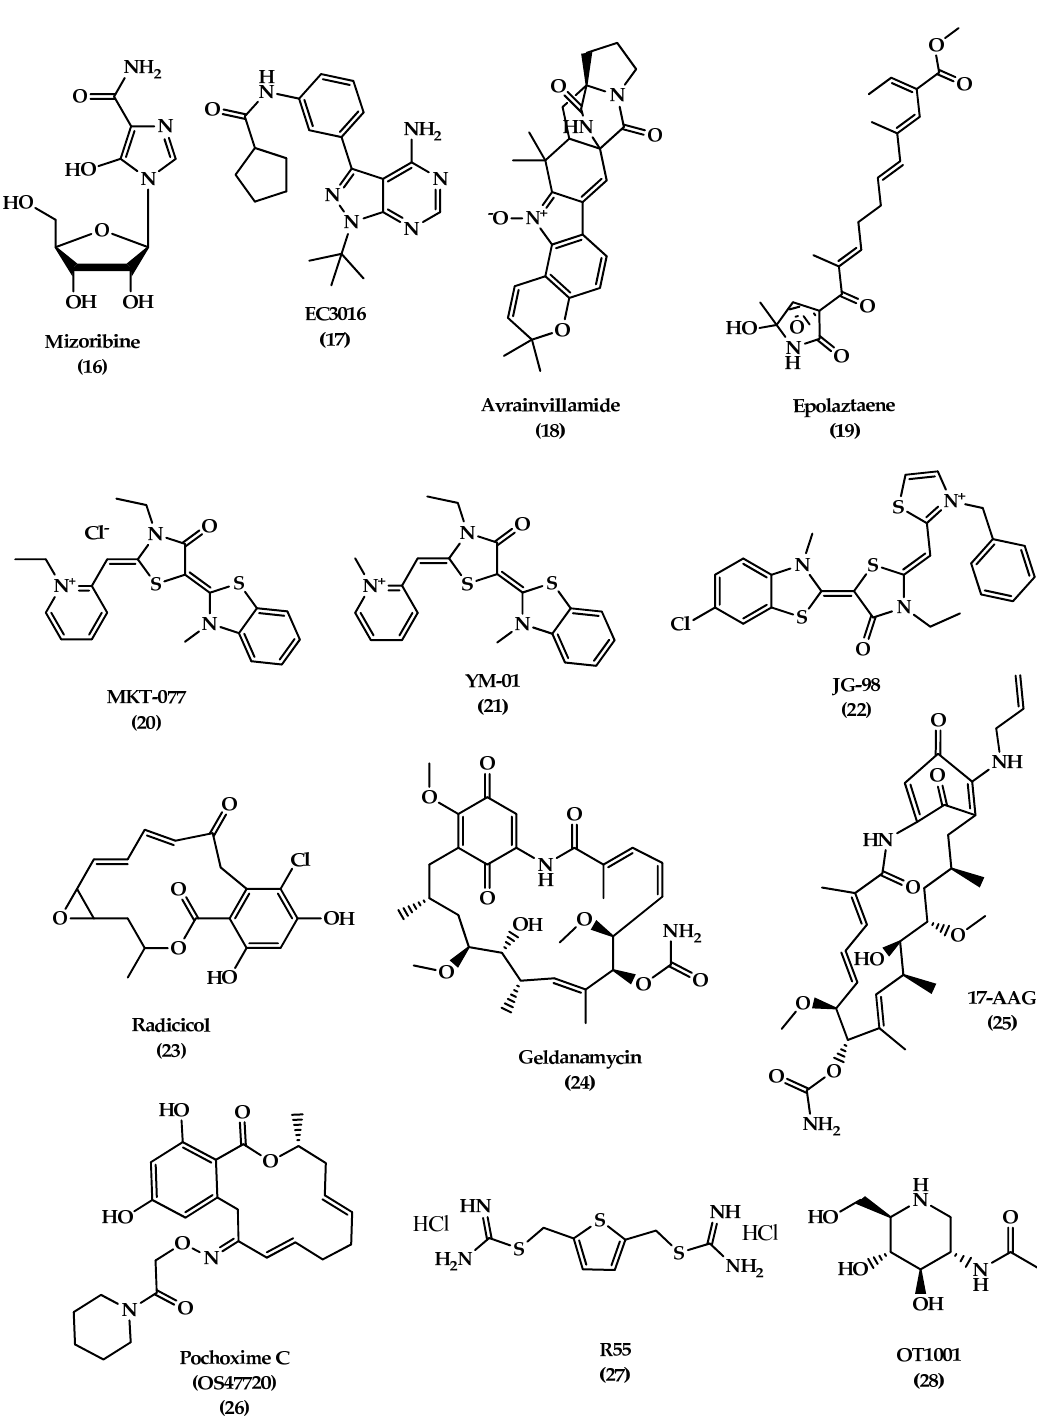
Figure 5. The chemical structures of different chaperone molecules: Mizoribine 16 , EC3016 17 , Avrainvillamide 18 , Epolaztaene 19 , MKT-077 20 , YM-01 21 , JG-98 22 , Radicicol 23 , Geldanamycin 24 , 17-AAG 25 , Pochoxime C (OS47720) 26 , R55 27 , and OT1001 28 .